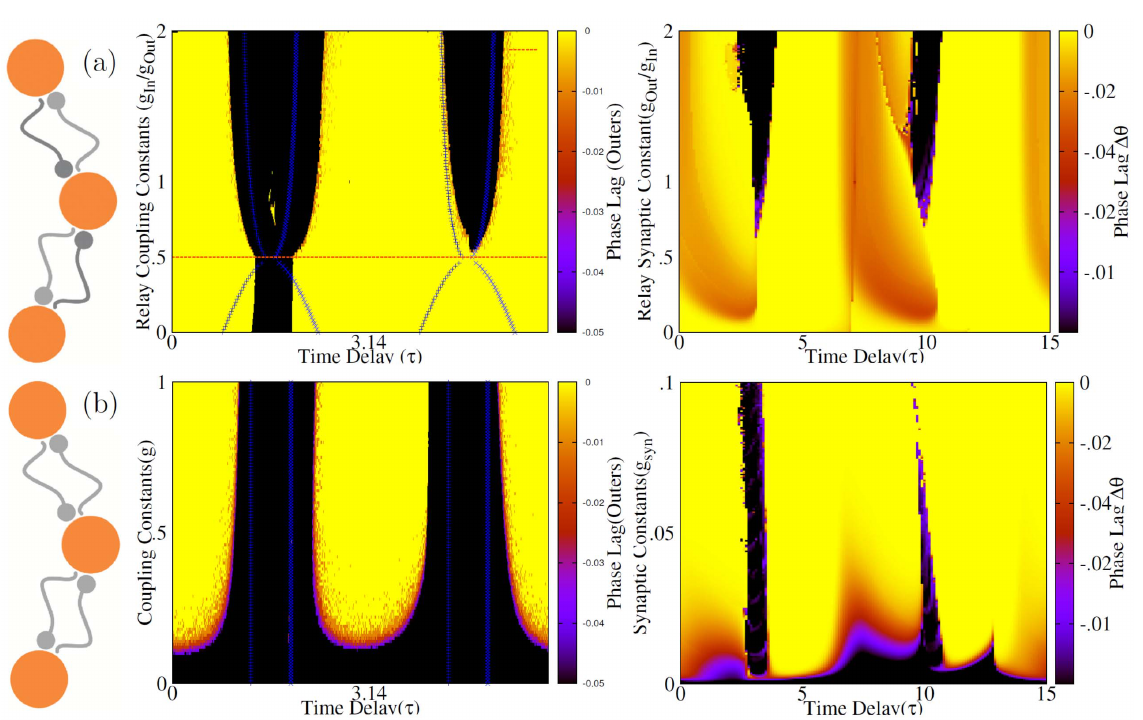
Fig. 8. Symmetric variation of synaptic constants. (a) Synaptic constants of incoming links to the relay neuron are changed while outgoing ones are kept ~ 1 ). Color code shows time lag of spiking of outer neurons, resulted from numerical experiments. Solid lines are drawn based on the analytic constant ( g out ~ 2 g synchrony is seen for almost all the values of delay time. For results, showing the domain of stability of synchronous state. Note that for g out in comparison the results for the homogeneous system are shown in (b) where all the synaptic constants are equal. In this case except for very small synaptic constants, the results are insensitive to the changes of synaptic strengths and can not results a synchronous state. Right panel show the similar results for HH